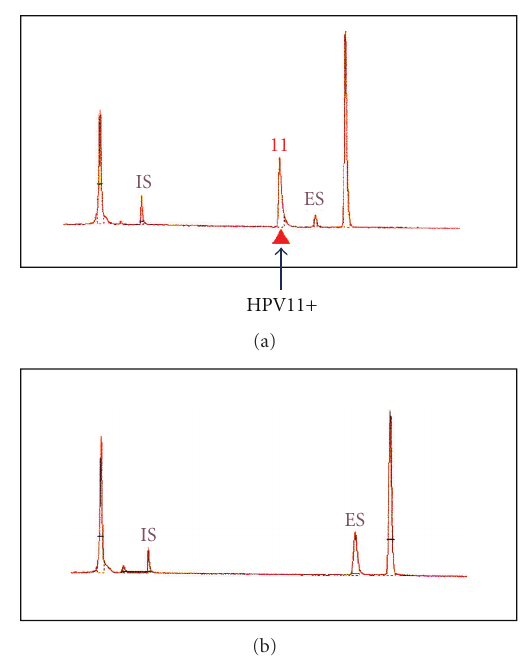
Figure 4: Detection of HPV sequences by the PapiPlex method. Up- per panel: urethral condyloma showing HPV11 sequences (arrow), lower panel: a squamous papilloma with no HPV